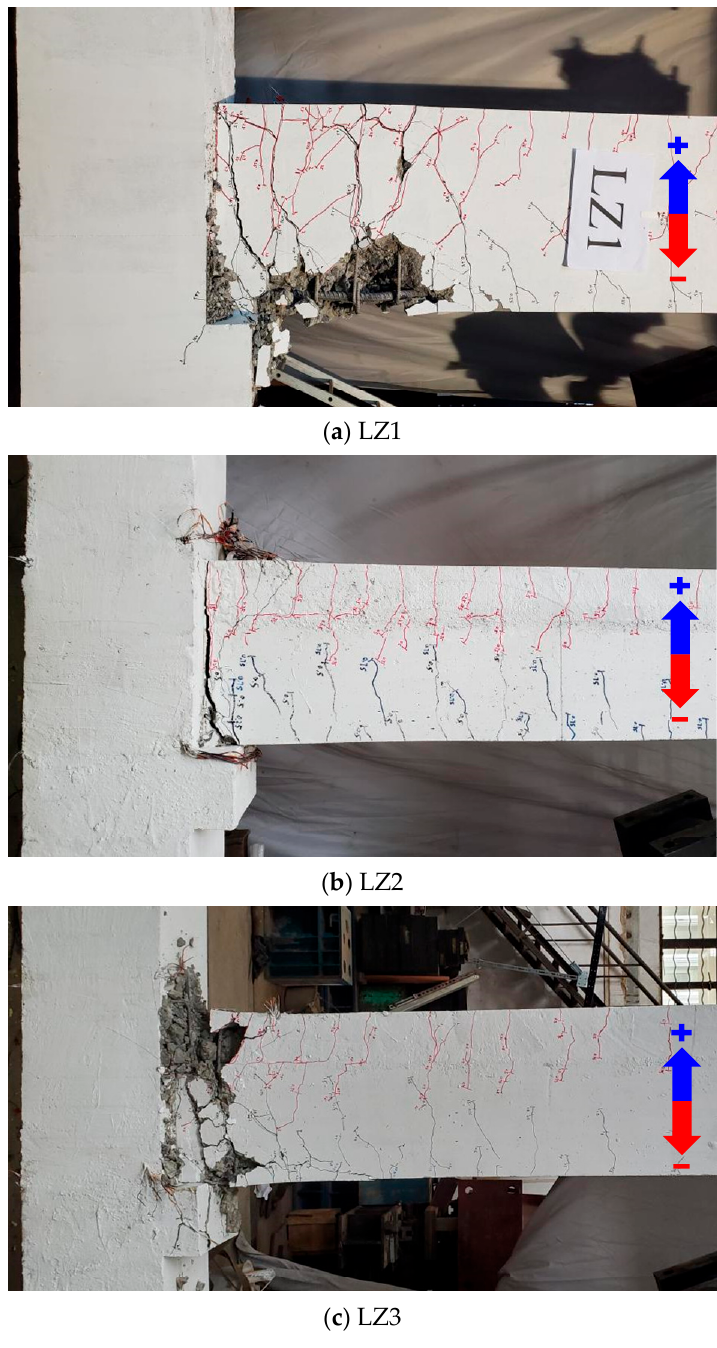
Figure 6. Photographs after the tests.